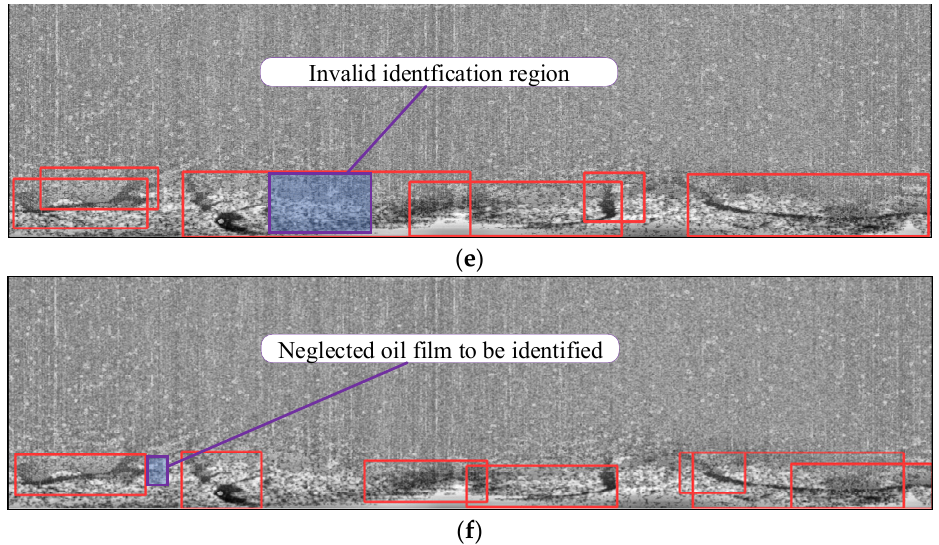
Figure 19. Oil film detection results of YOLO Deep Learning Network with different settings. ( a ) epochs: 100, batch size: 16, image size: 128 × 128; ( b ) epochs: 300, batch size: 16, image size: 128 × 128; ( c ) epochs: 200, batch size: 8, image size: 128 × 128; ( d ) epochs: 200, batch size: 32, image size: 128 × 128; ( e ) epochs: 200, batch size: 16, image size: 256 × 256; ( f ) epochs: 200, batch size: 16, image size: 128 × 128.